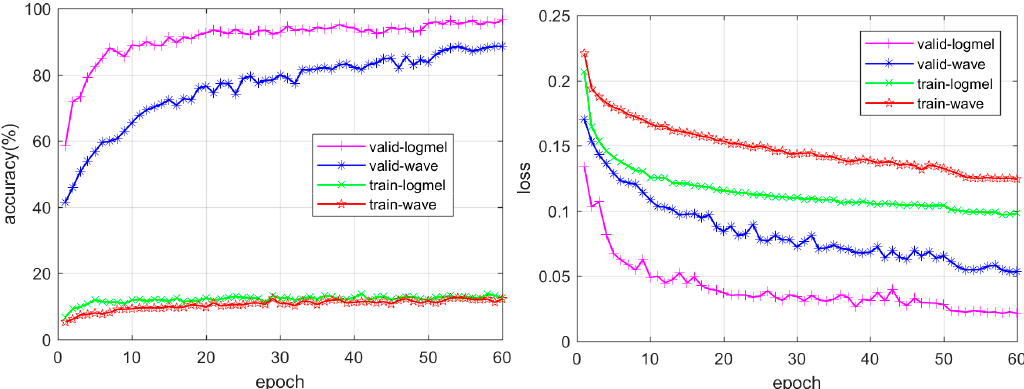
Figure 2. The evolution of accuracies and losses in the training based on the ResN-logm and ResN-wav models (color online).